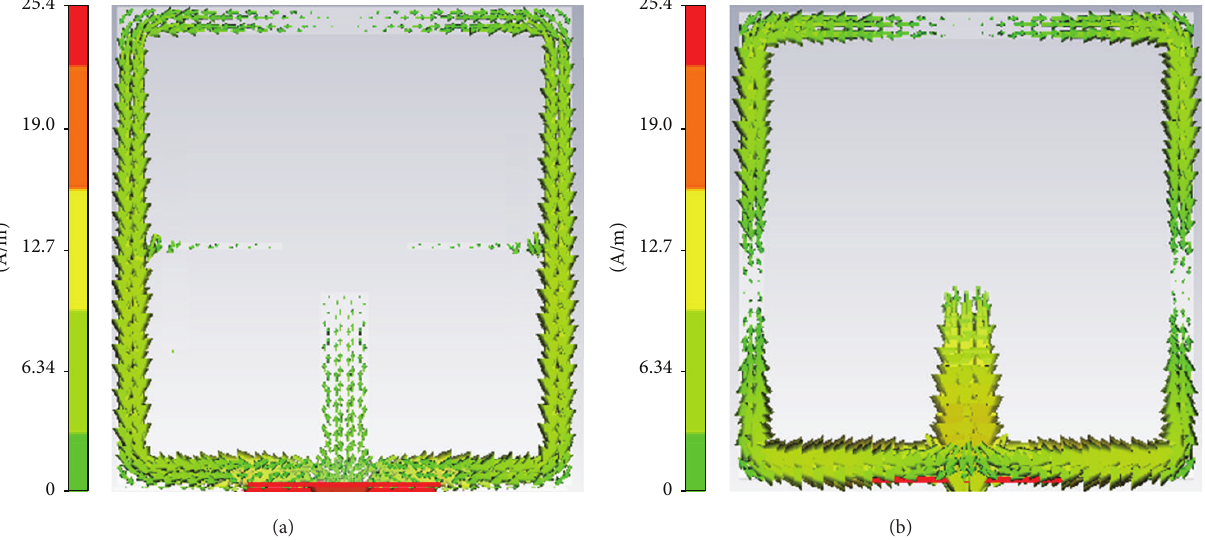
Figure 3: Surface current distribution (a) 2.4 GHz and (b) 4.3 GHz.